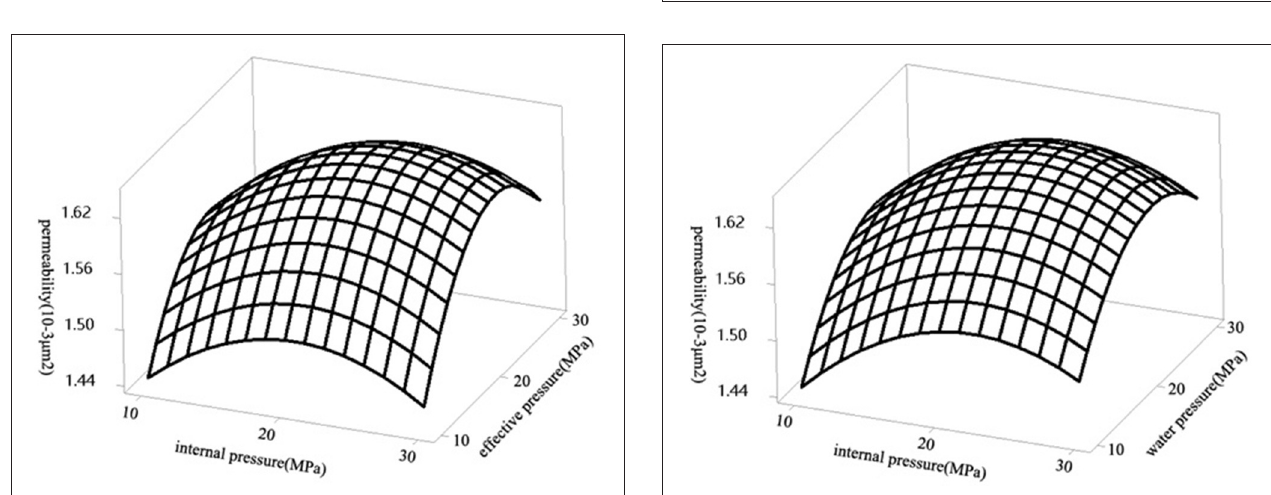
FIGURE 7 | Surface of permeability (10 − 3 µ m 2 ) vs. effective pressure and internal pressure.